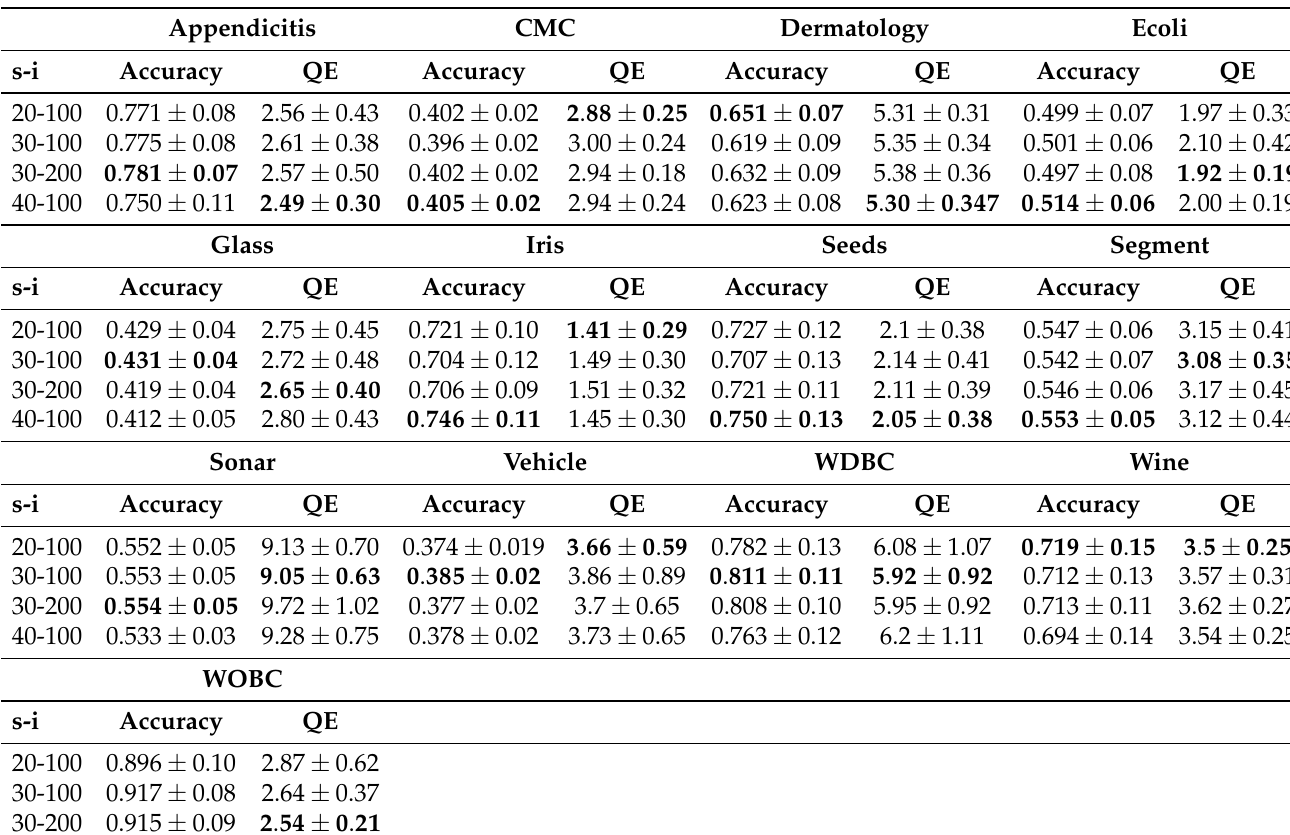
Table 9. Performances of CM-BBPSO using different swarm size (s) and maximum iteration (i), s-i with the best result produced by the s-i setting for each dataset presented in